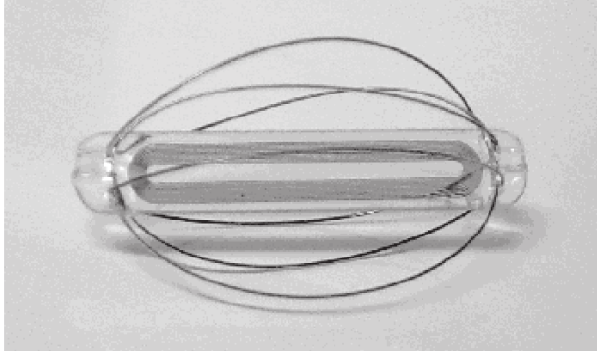
Figure 1 – EndoSure TM wireless pressure sensor.